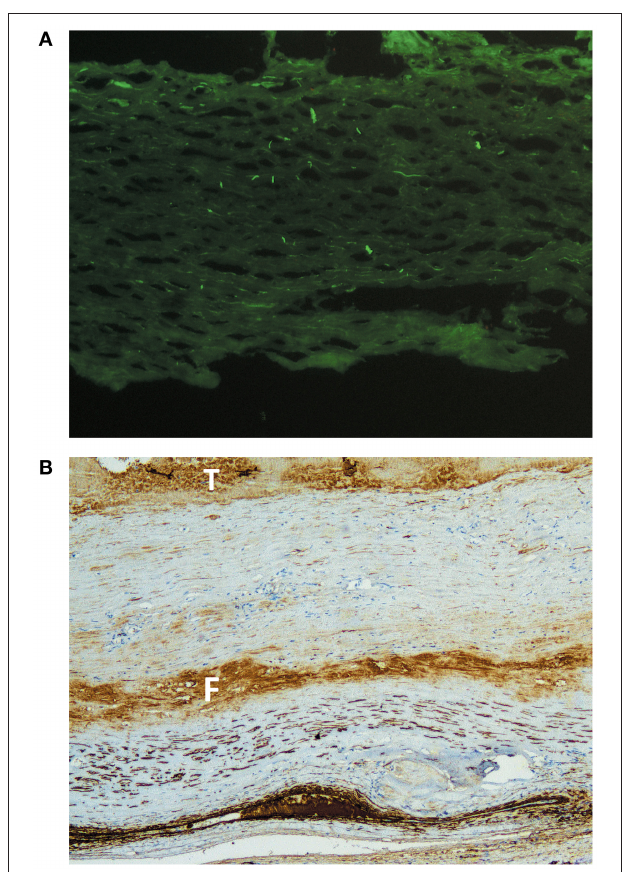
FIGURE 3 | Immunohistological analysis of a degenerated cryopreserved artery allograft. (A) Immunofluorescence staining of a degenerated cryopreserved artery excised 24 months after transplantation. The sample shows interstitial immune complex deposition, positive for IgG. Original magnification × 20. (B) Immunohistochemical analysis of the same allograft. IgG deposits located predominantly in the neointima, with a higher density in the subendothelial area (SE). Original magnification ×